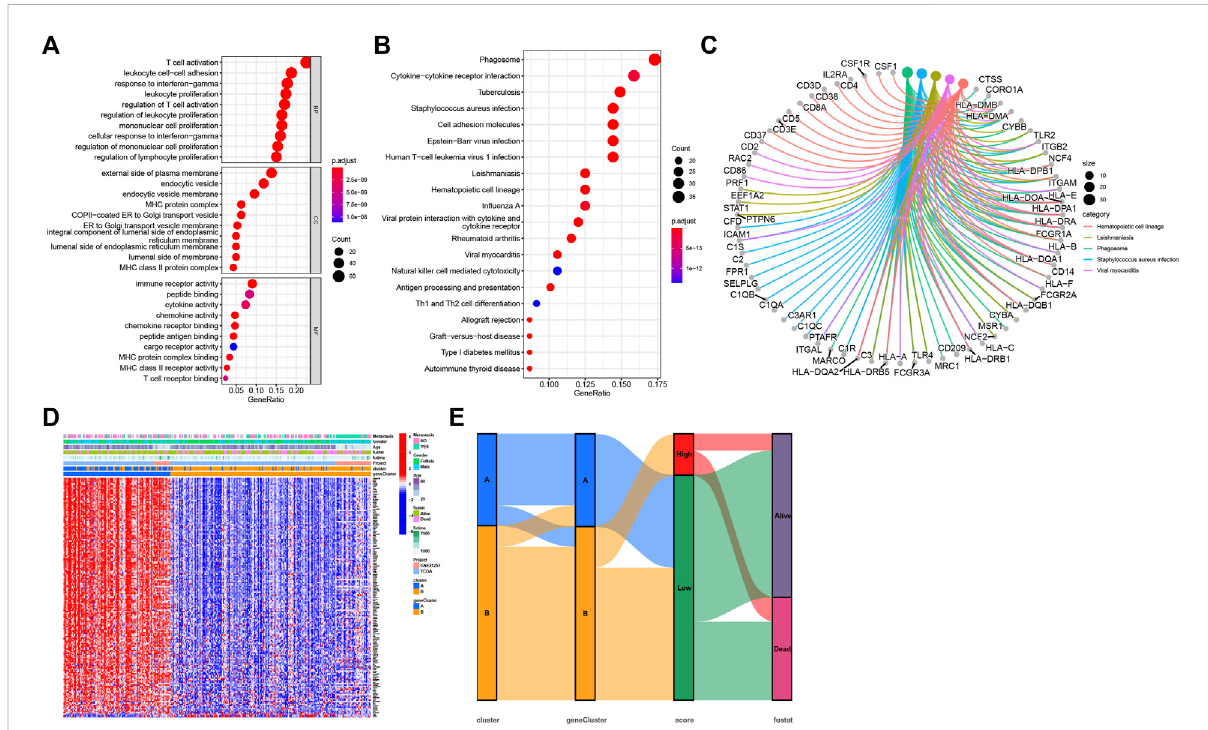
FIGURE 6 Functionalenrichmentanalysis. (A) GOenrichmentanalysisofDEGs,includingBP,CC,andMF. (B) Thetop20termsofKEGGresults. (C) Thetop fi ve terms of KEGG results with detailed DEGs. (D) The normalized expression of 173 DEGs grouping by geneClusters and the distribution of corresponding clinical features. (E) The sankey diagram visualized the correlation between cluster, geneCluster, necroptosis score, and survival status of SARC